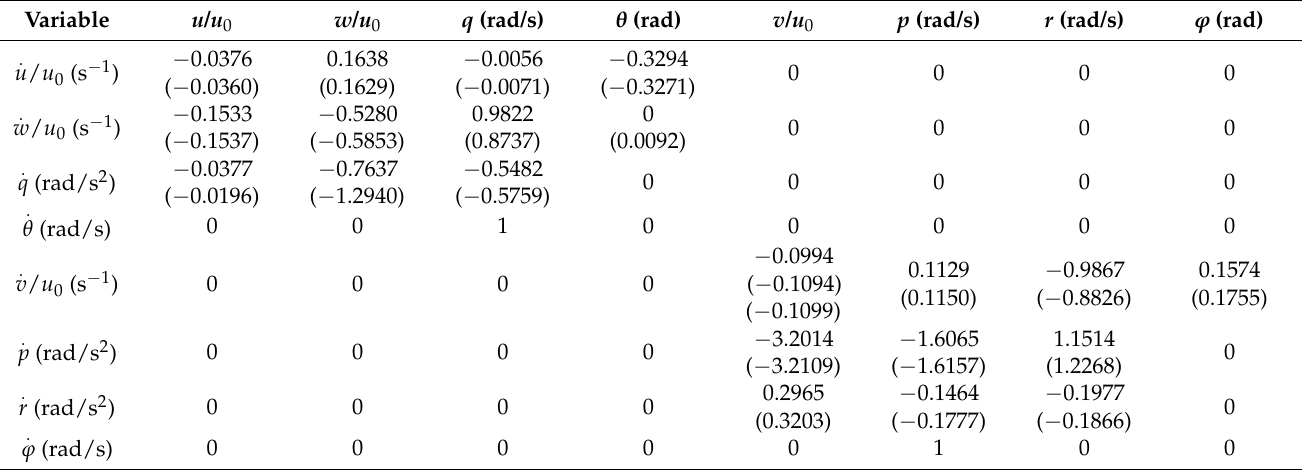
Table 13. CFD–RANS (extrapolated) 8 × 8 stability matrix for flight condition 6 in Tables 4 and